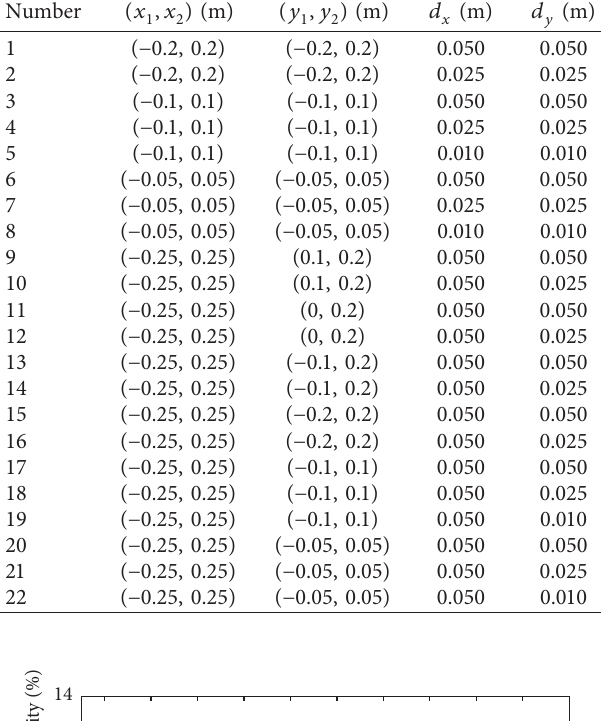
Table 1: Parameters groups ( x simulations.